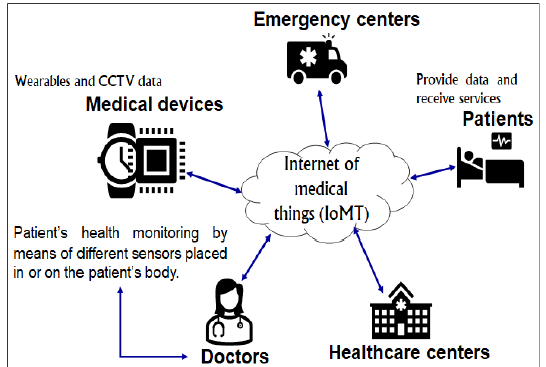
Figure 5. System-level overview of IoT/IoMT technology in realistic scenarios.